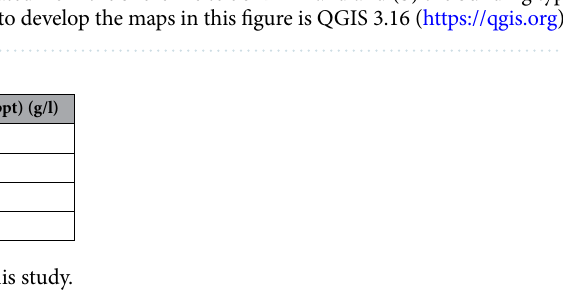
Figure 2. ( a ) Number of buildings located from the shoreline to 50 km inland and ( b ) the building types in Mobile County, AL. The software used to develop the maps in this figure is QGIS 3.16 (https:// qgis. org).